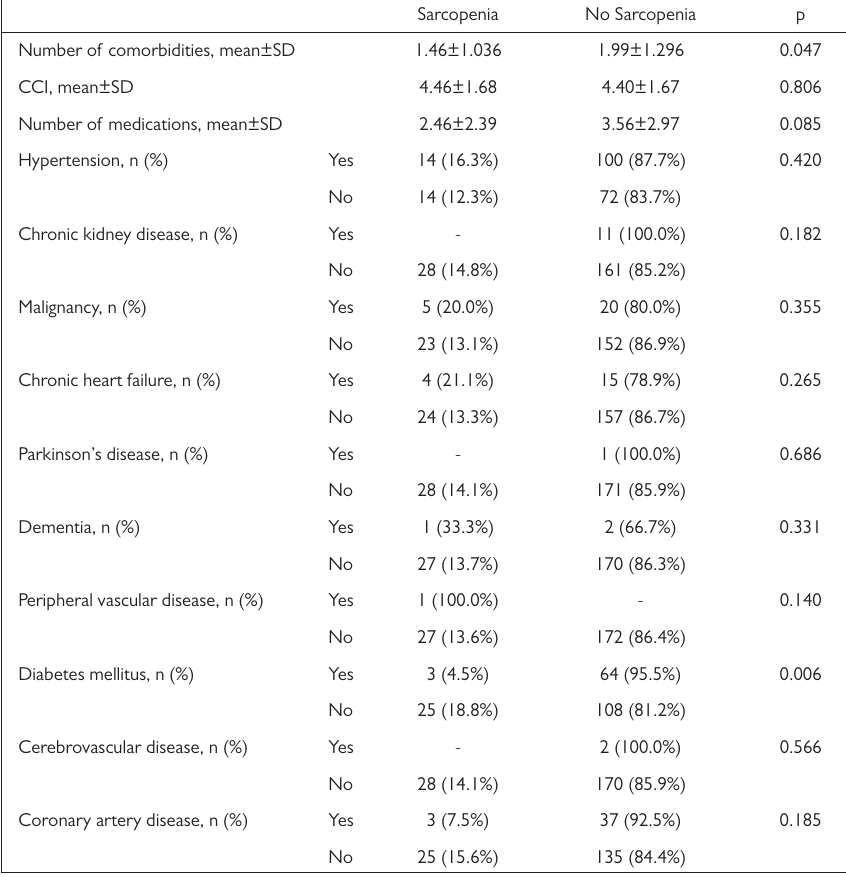
Table 2. Association between sarcopenia and